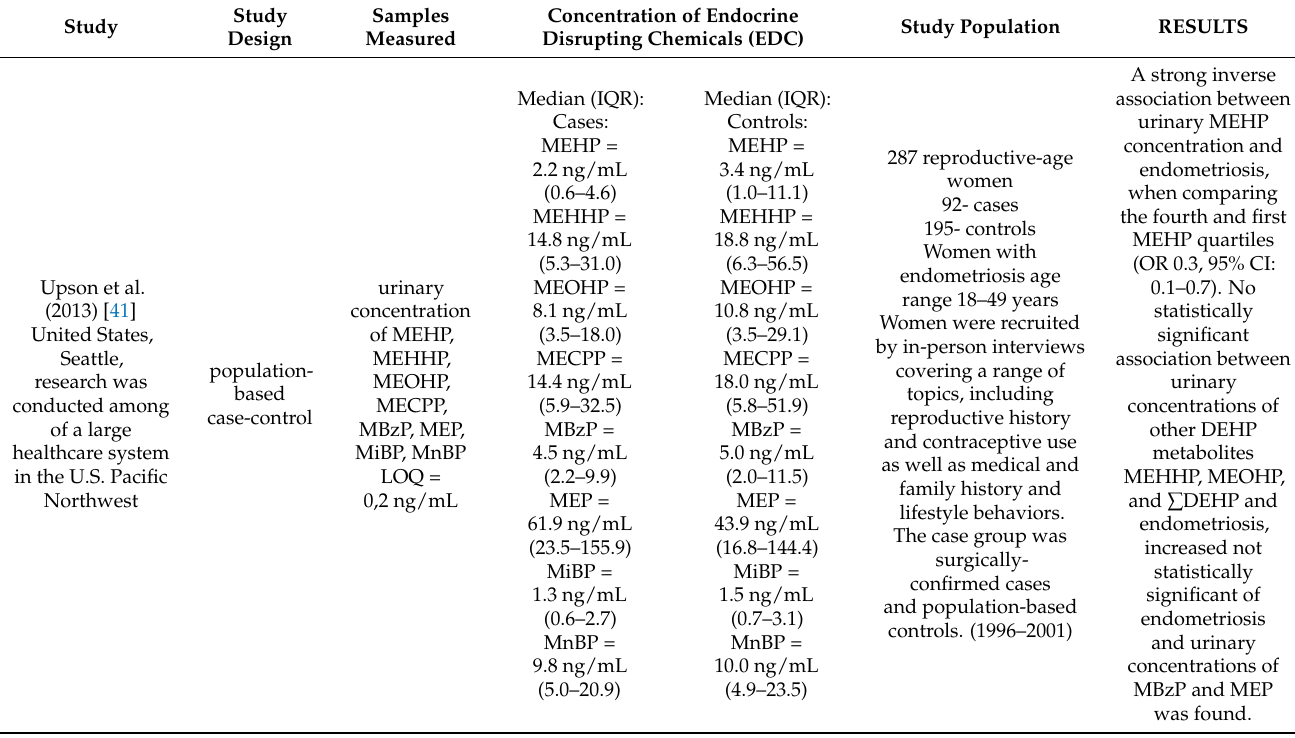
Table 1. Exposure to phthalate and